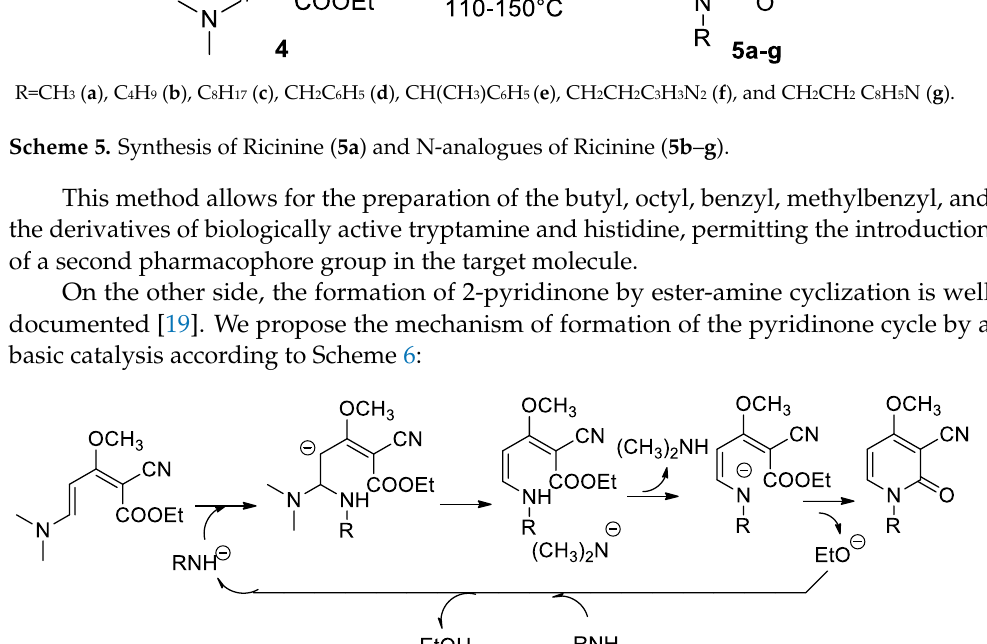
Table 1. Synthesis of Ricinine ( 5a ) and N-analogues of Ricinine ( 5b – g ).